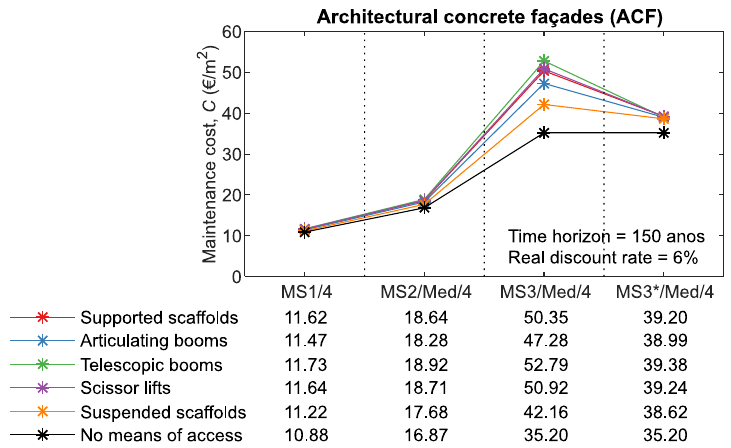
Figure 7. Sensitivity analysis of the different means of access in ACF maintenance strategy costs for a time horizon of 150 years.